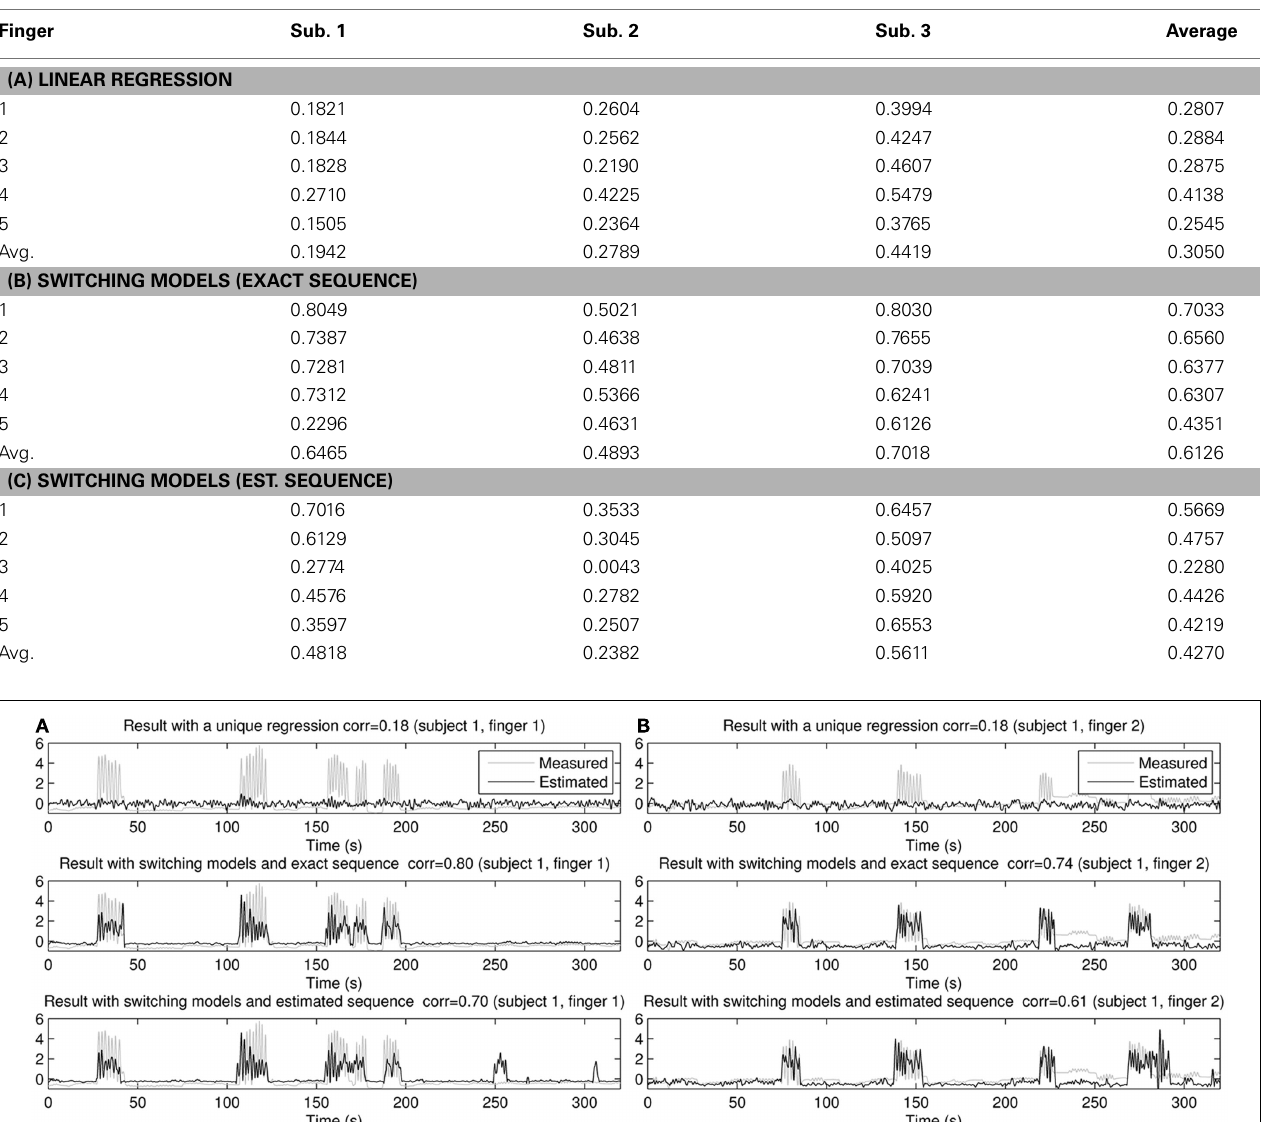
Table 3 | Correlation between measured and estimated movement for a global linear regression (A), switching decoder with exact sequence (B), and switching decoder with an estimated sequence (C).